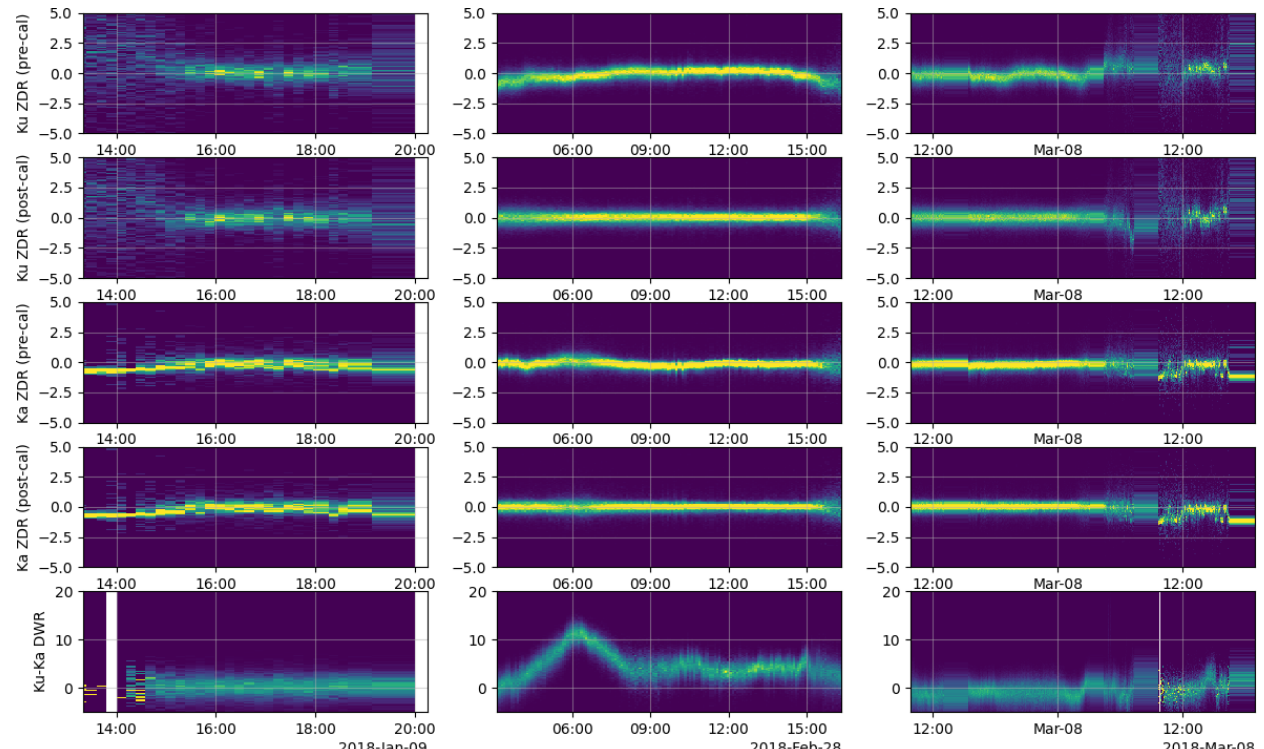
Figure 2. Time-series histograms of near-zenith Ku Z dr before (top row) and after (second row) offsets were applied. Similar histograms are presented for Ka-band data in rows three and four. The fifth row displays the time-series histogram of the Ku–Ka DWR where Ku reflectivity is less than 10dBZ within 10km of the radar. Colors are indicative of relative occurrence, normalized at each time step.